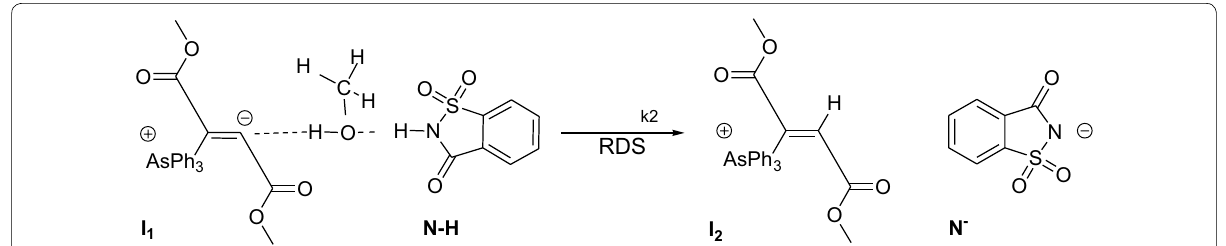
Fig. 11 Comparison between the steric effect of CH 3 OH or C 2 H 5 OH on a proton transfer process between the N – H and I